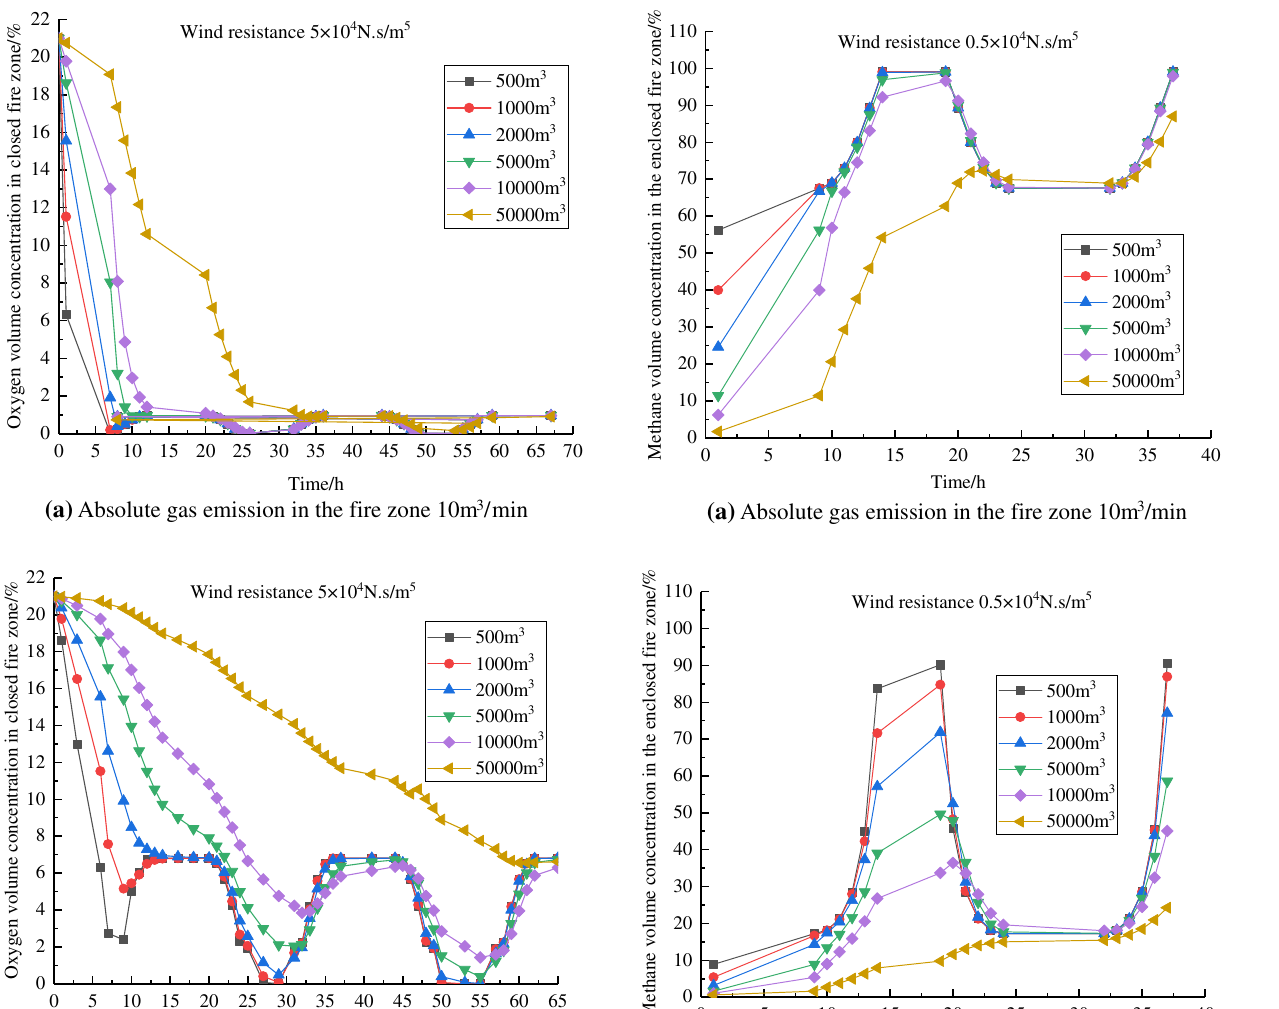
(b) Absolute gas emissionin the fire zone 1m 3 /min Fig. 9 The different gas emission, different volume of fire zones, and large wind resistance. The relationship of oxygen concentration in the fire zone changing with time after the completion of sealing at 13:00